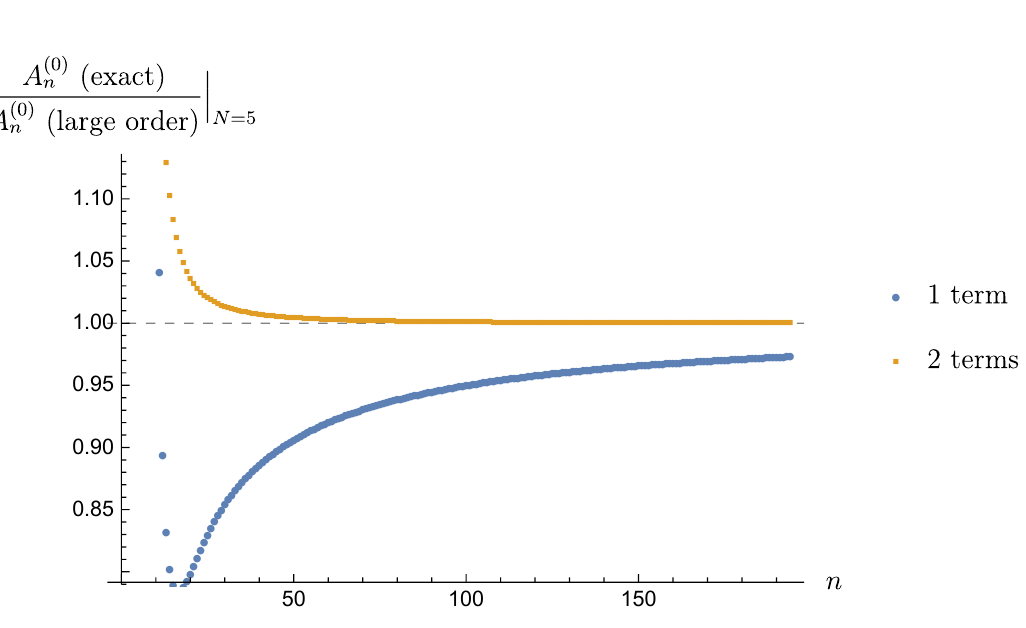
Figure 4 . Ratio of the exact perturbative coe(cid:14)cients A (0) n ( N ) from (5.2), divided by the resurgent large-order growth expression (5.4). Both plots are for N = 5, and include just the (cid:12)rst term in (5.4) [blue circles] or the (cid:12)rst two terms [gold squares]. Both sequences have been accelerated using Aitken